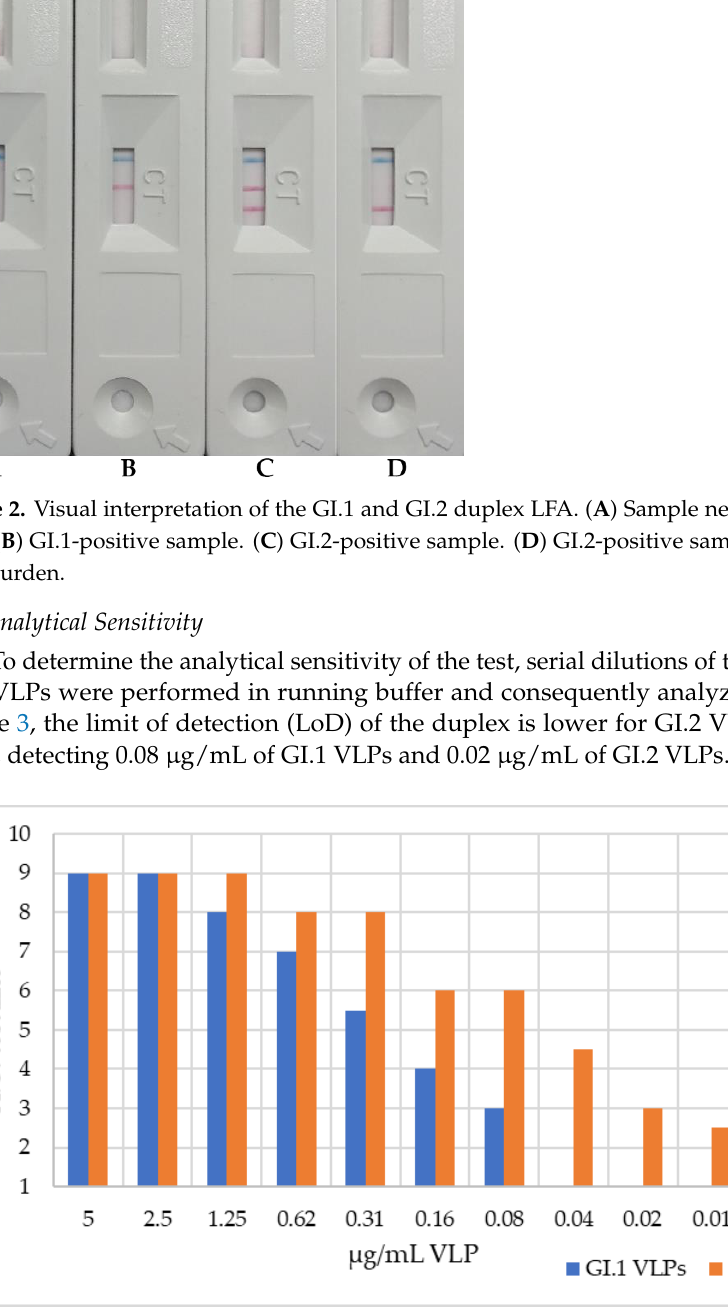
Figure 3. Analytical sensitivity of the duplex LFA. Serial dilutions of GI.1 VLPs and GI.2 VLPs and their corresponding result